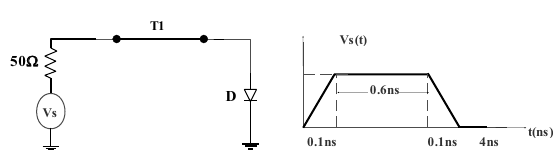
Fig. 11. Electrical representation of the line in Fig. 1 with nonlinear loads.